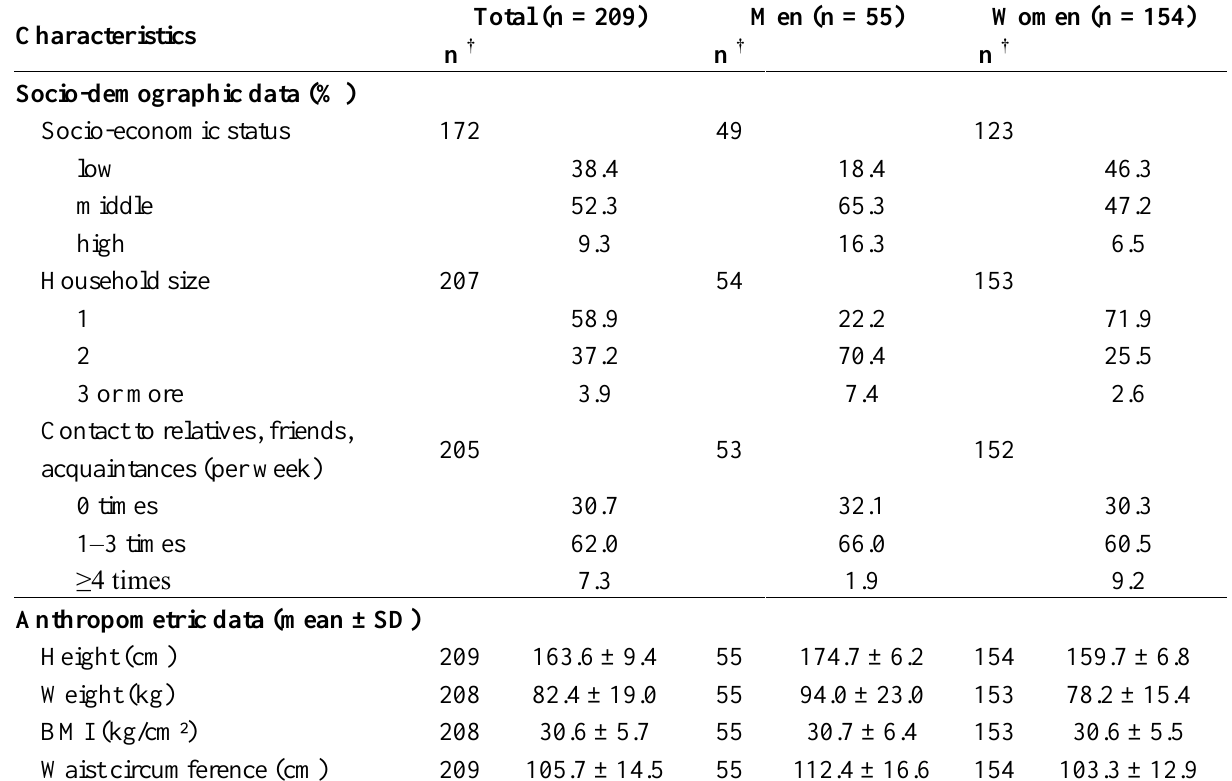
Table 6. Patient characteristics at